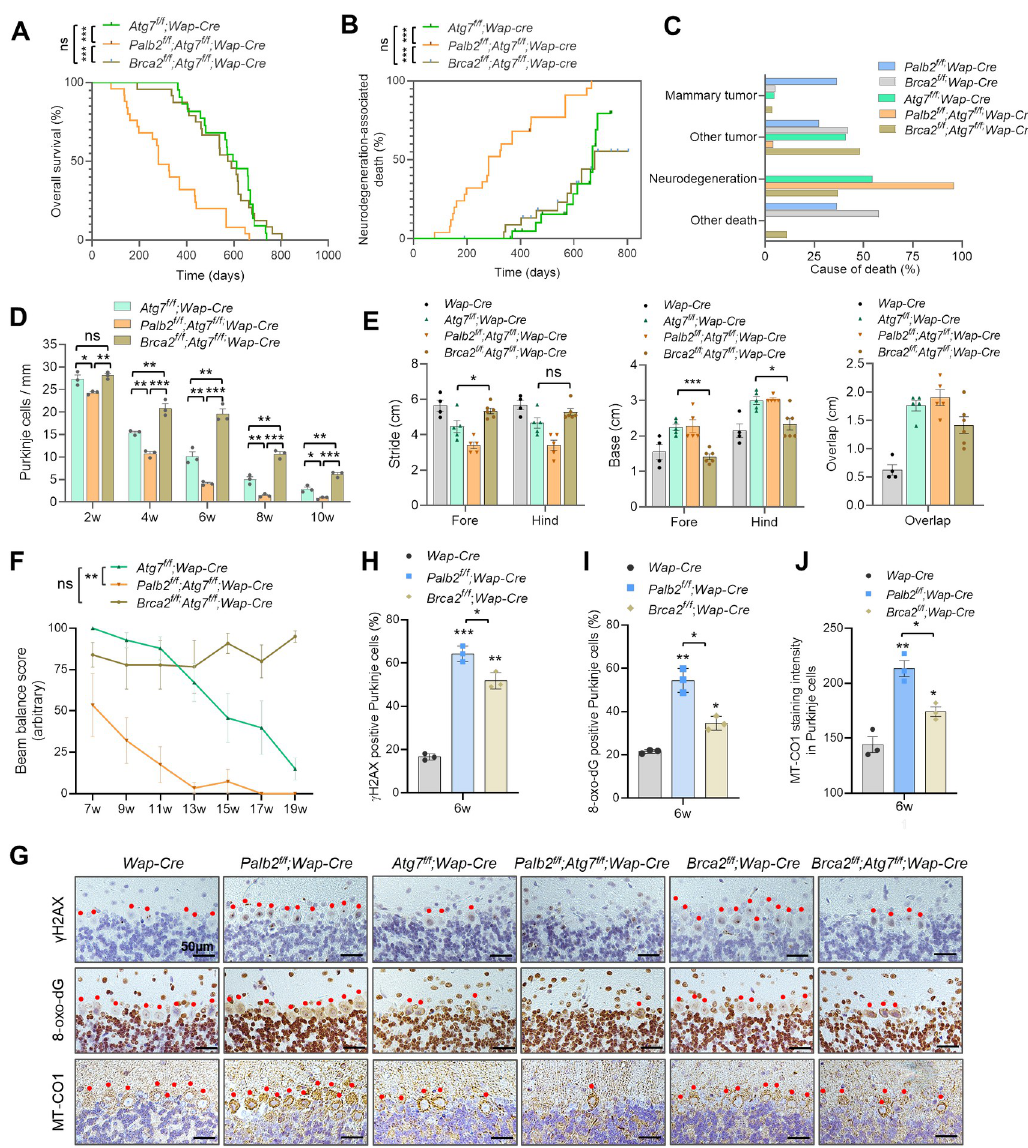
Fig 6. Comparative analyses of the impacts of Brca2 and Palb2 deletions in wt and Atg7 -CKO mice. (A-C) Overall survival (A), neurodegeneration-associated death (B) and cause of death (C) of the CKO mice. Atg7 f/f ; Wap-Cre , n = 22; Palb2 f/f ; Atg7 f/f ; Wap-Cre , n = 25; Brca2 f/f ; Atg7 f/f ; Wap-Cre , n = 24. (D) Purkinje cell numbers in CKO mice at 2 to 10 weeks of age. n = 3 mice per genotype per time point. (E) Footprint measurements of 6 weeks old CKO mice. n = 5–7 mice per genotype. (F) Beam balance scores of the CKO mice at different ages. (G) Representative images of γ H2AX, 8-oxo-dG and MT-CO1 IHC in the cerebellum of 6 weeks old CKO mice. Red dots indicate Purkinje cells. Scale bar = 50 μ m. (H-J) Quantification of γ H2AX positivity (H), 8-oxo- dG positivity (I) and MT-CO1 staining intensity (J) in Purkinje cells (n = 3 mice per genotype).